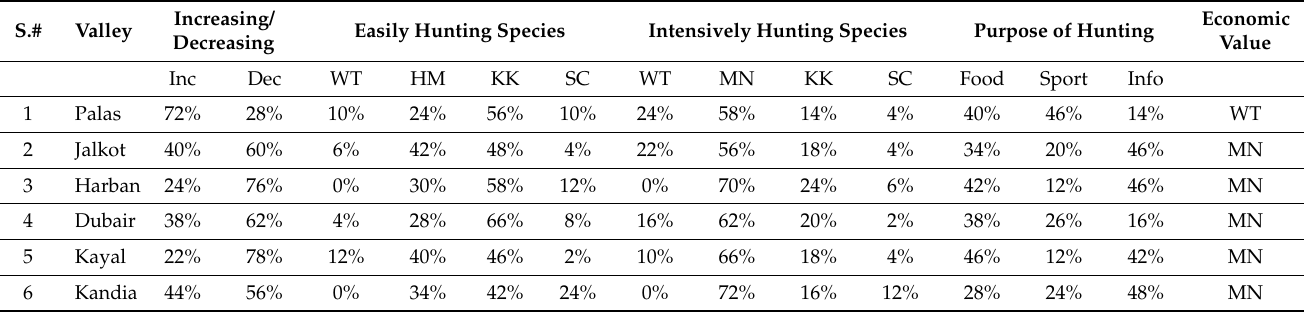
Table 6. Illegal hunting of Himalayan pheasants, hunting preference, and purpose of hunting in the study